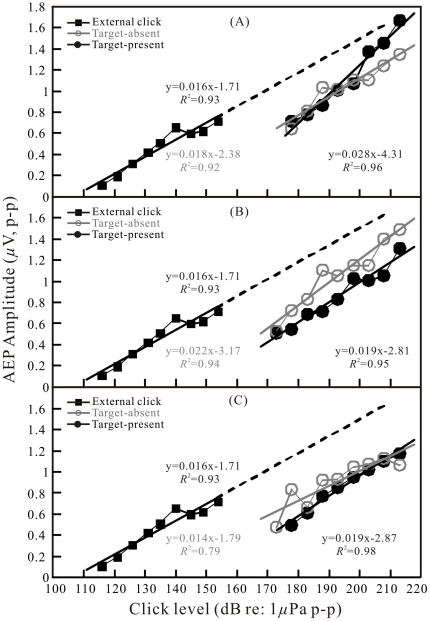
Same as in
Fig. 5
 but for the target with −28-dB target strength.